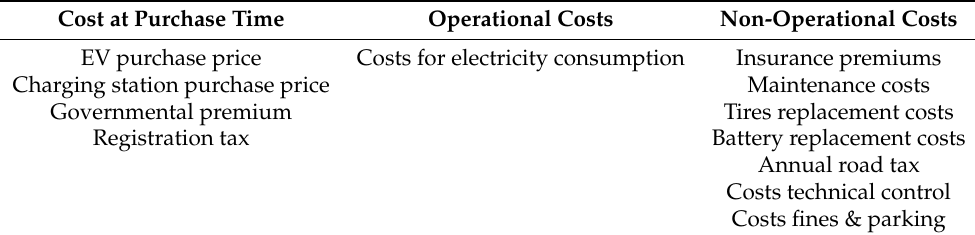
Table 1. Overview of the considered costs for the TCO calculation [12,14,19]. Cost at Purchase